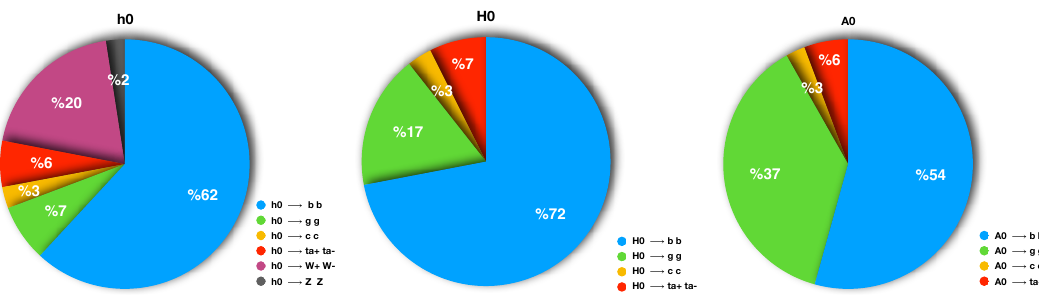
Figure 7 . The branching ratios of all the neutral Higgs bosons for the point de(cid:12)ned in table 1. be considered as advantageous, they could be cumbersome due to the extra Z-boson at the (cid:12)nal state and the leptonic decays of the W-boson. Therefore, the hadronic decay channels of h 0 boson promise more in the extraction of its